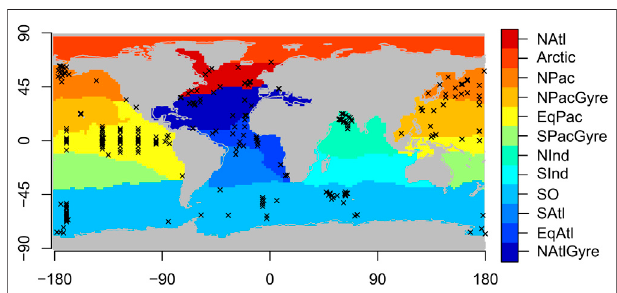
FIGURE 1 | Biogeochemical provinces with station locations of sediment trap observations overlain. Locations are shown for pro fi les with more than two observations at a pro fi le location at a particular